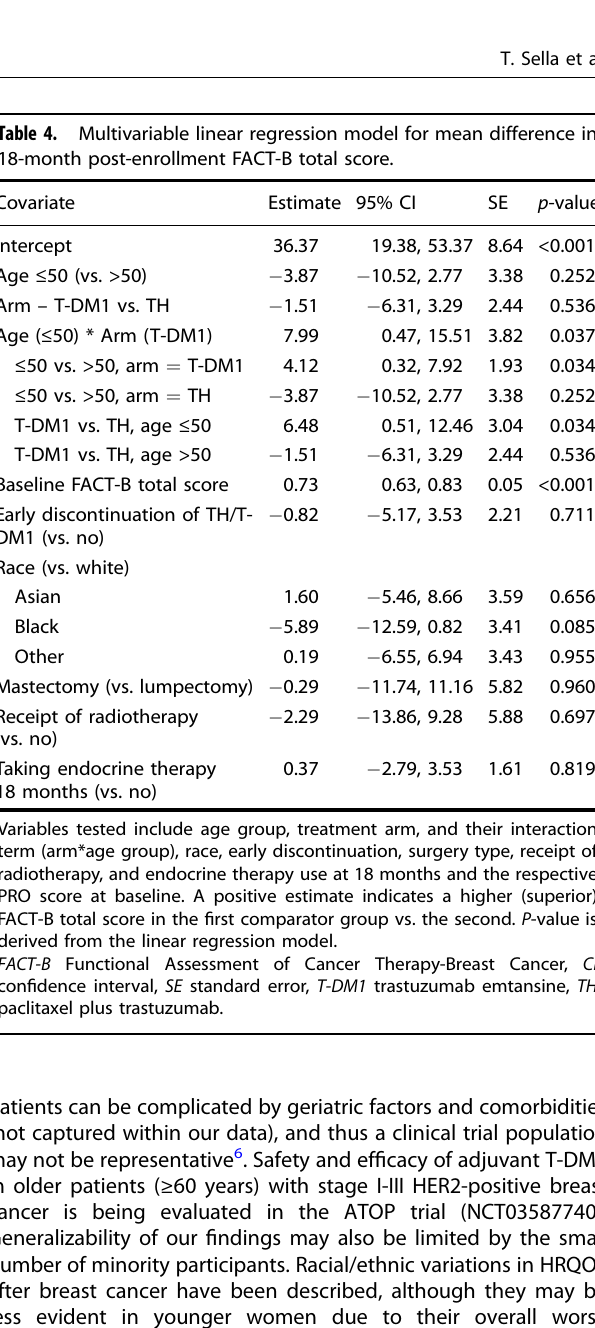
course of T-DM1 from ATEMPT 2.0, will continue to shape